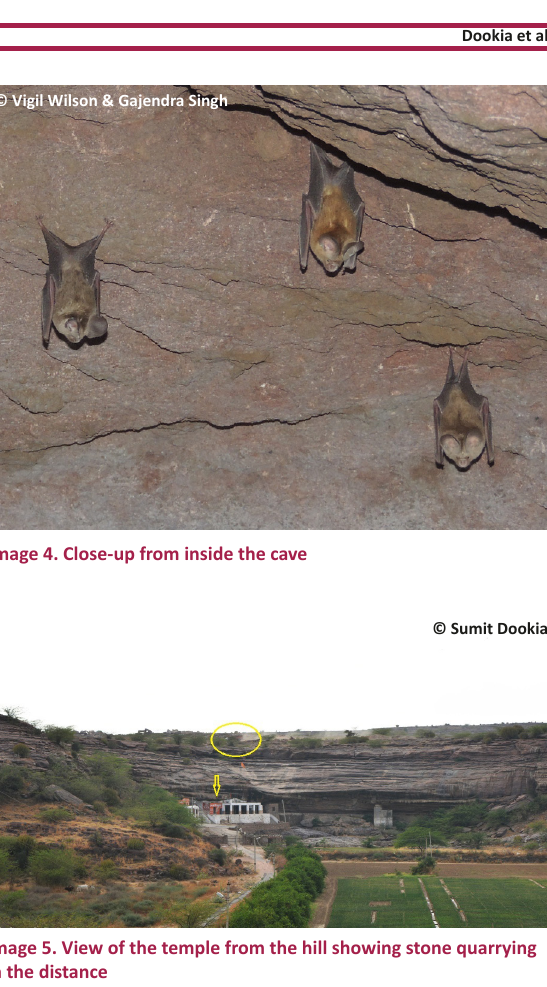
Image 5. View of the temple from the hill showing stone quarrying in the distance